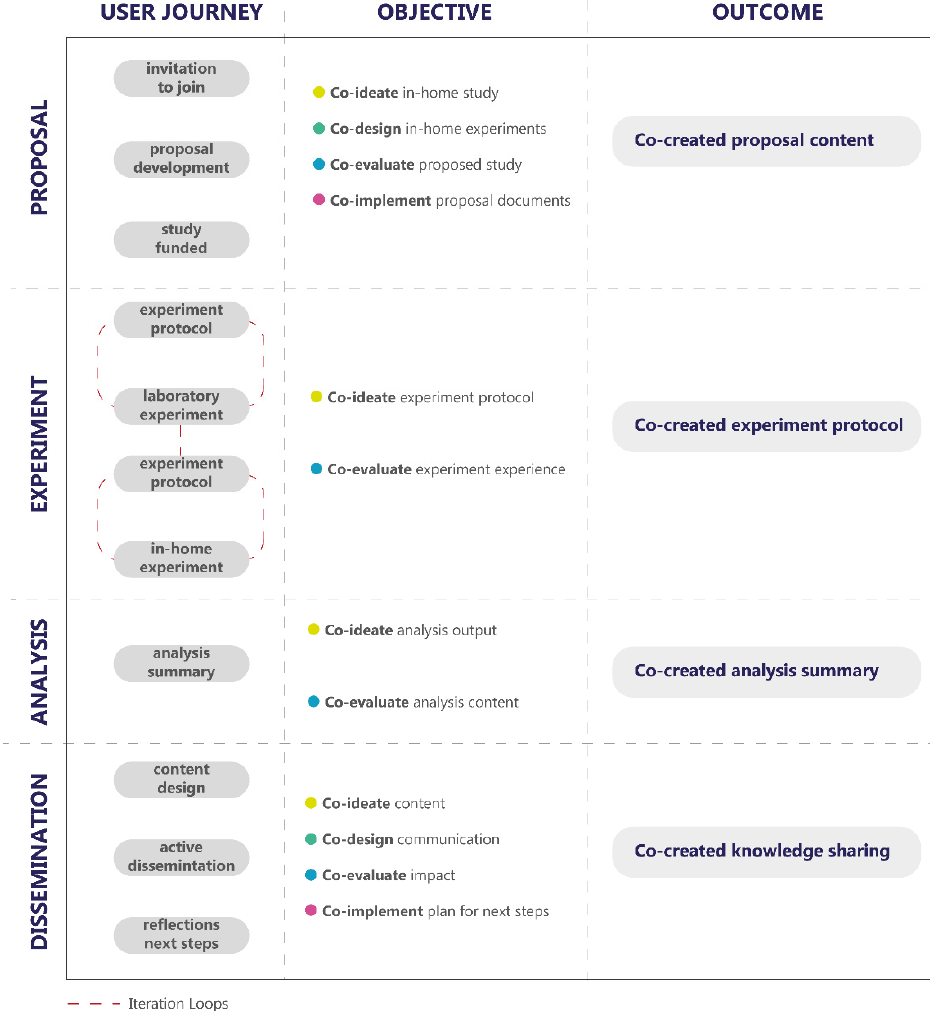
Figure 3. Co-creation for an in-home trial—a potential user journey map.